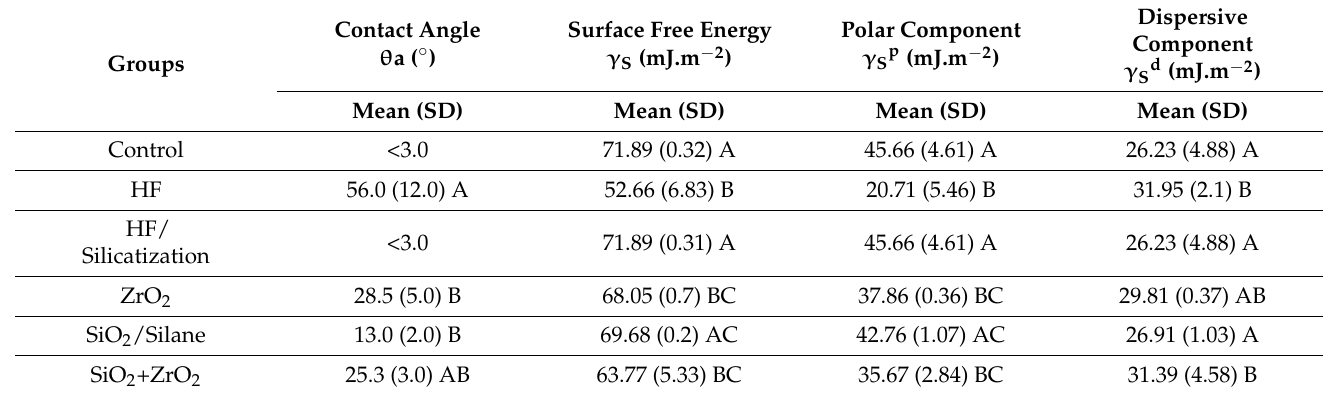
Table 1. The contact angles ( θ a) and surface free energy ( γ s ), and γ s = γ Sp (polar component) + γ Sd (dispersive component) values after the different surface treatments.